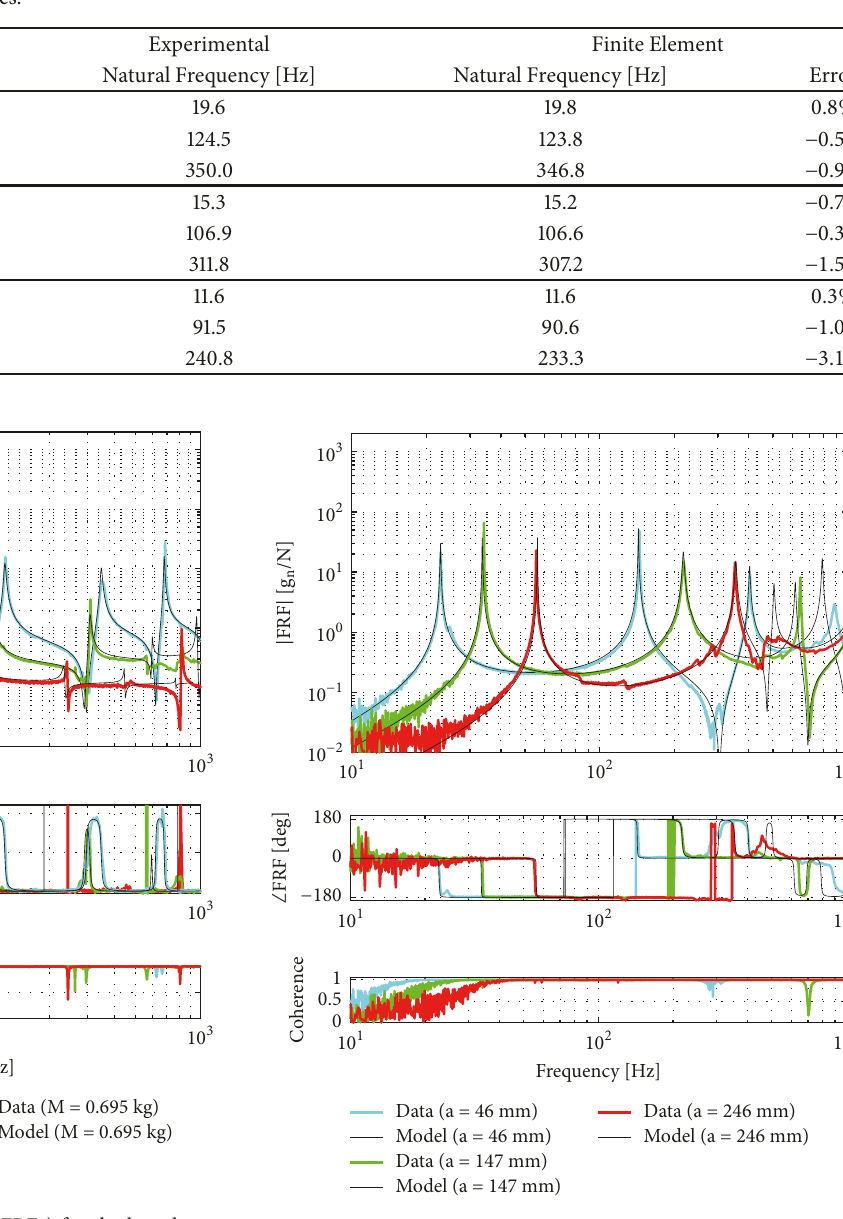
Figure 3:Frequencyresponsefunctions (FRFs)for the DROPBEAR with the rollers in three different positions: 46mm, 147mm, and 246mm. Data is from the tip accelerometer and impacts at 305mm (12in) from the base. Note that 𝑔 𝑛 = 9.81 m ⋅ s −2